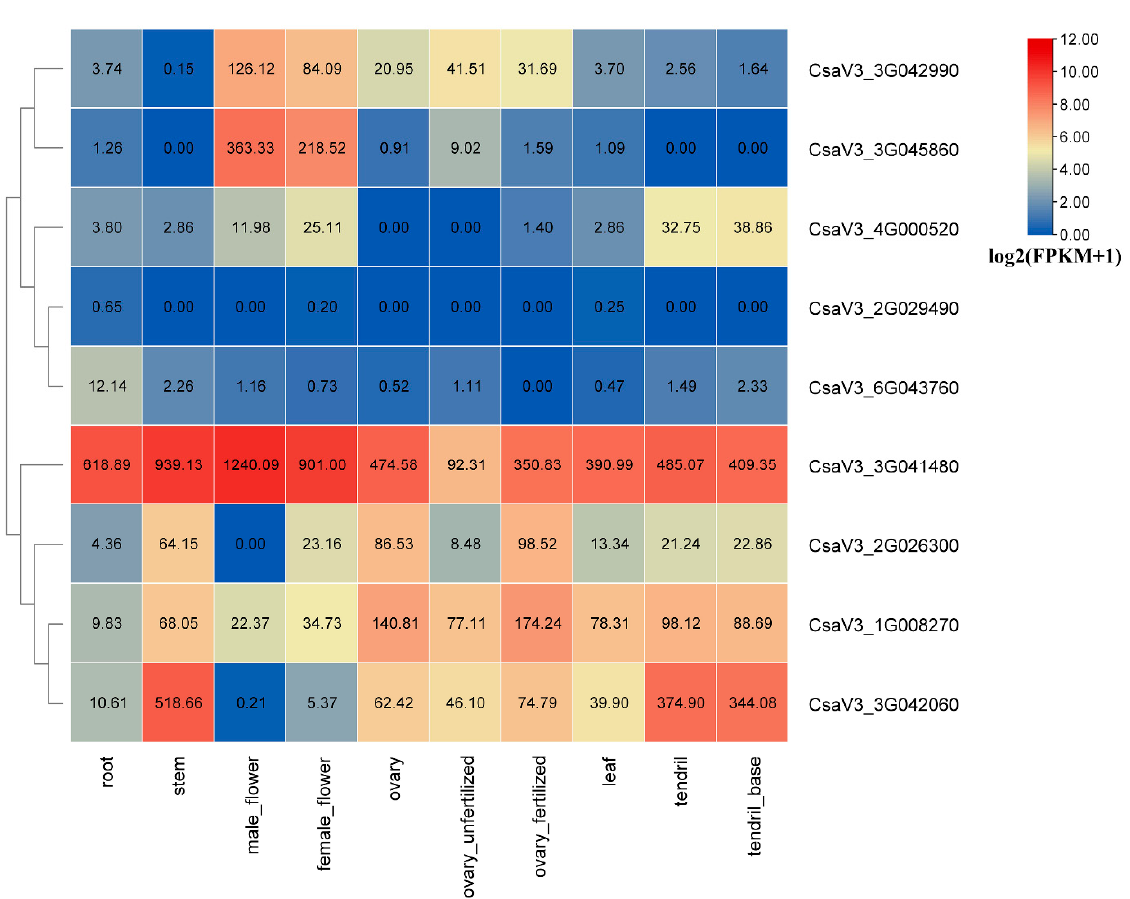
Figure 5. Expression heatmap of cucumber GASA gene family in different tissues. The data in the boxes indicate the original FPKM values.